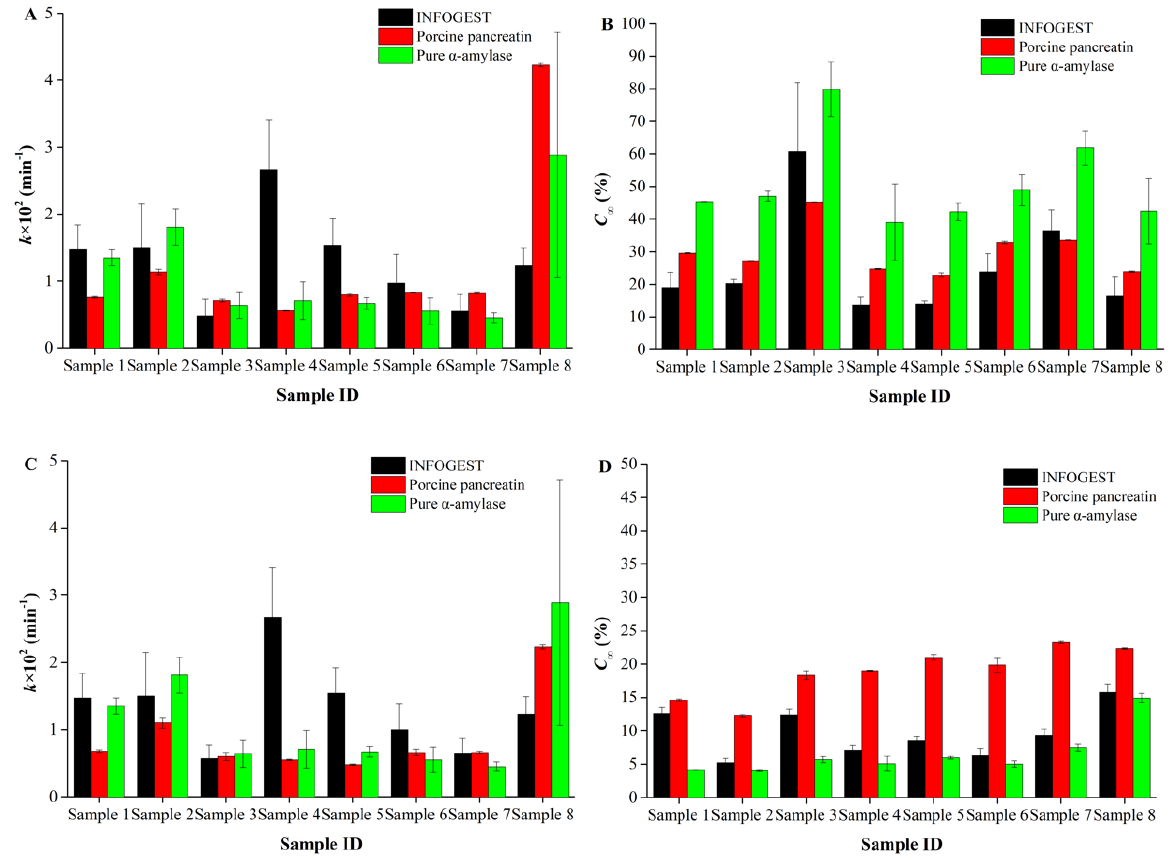
Figure 3. Fitting parameters of the in vitro digestograms using the single first-order kinetic (SK) model. ( A , B ) are the fitting results of the total percentage of starch digested; ( C , D ) are the fitting results of the reducing-sugar content, which was normalized to the total weight of carbohydrate. Data is based on duplicate measurements.